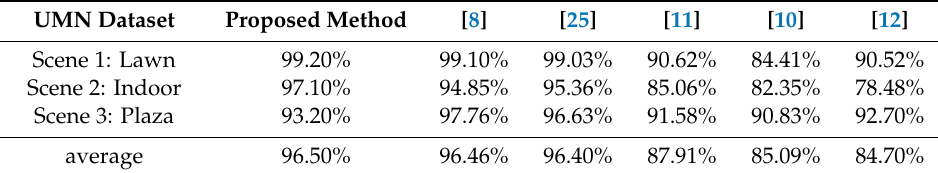
Table 2. Accuracy comparison with state-of-the art methods on the UMN dataset.